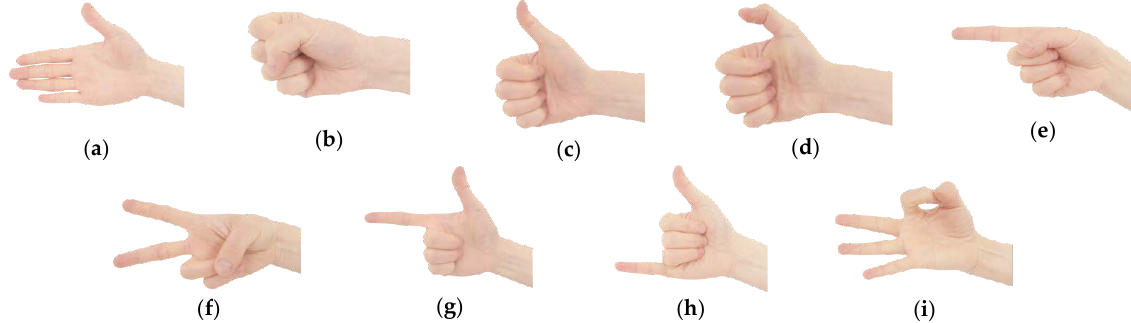
Figure 3. Schematic diagram of nine kinds of gestures: ( a ) five fingers extended; ( b ) five fingers closed; ( c ) extended thumb; ( d ) flexion of thumb; ( e ) extended index finger; ( f ) extended index and middle finger; ( g ) extended thumb and index finger; ( h ) extended thumb and pinkie; ( i ) flexion of thumb and index finger. Table 2. Description of nine kinds of gestures.